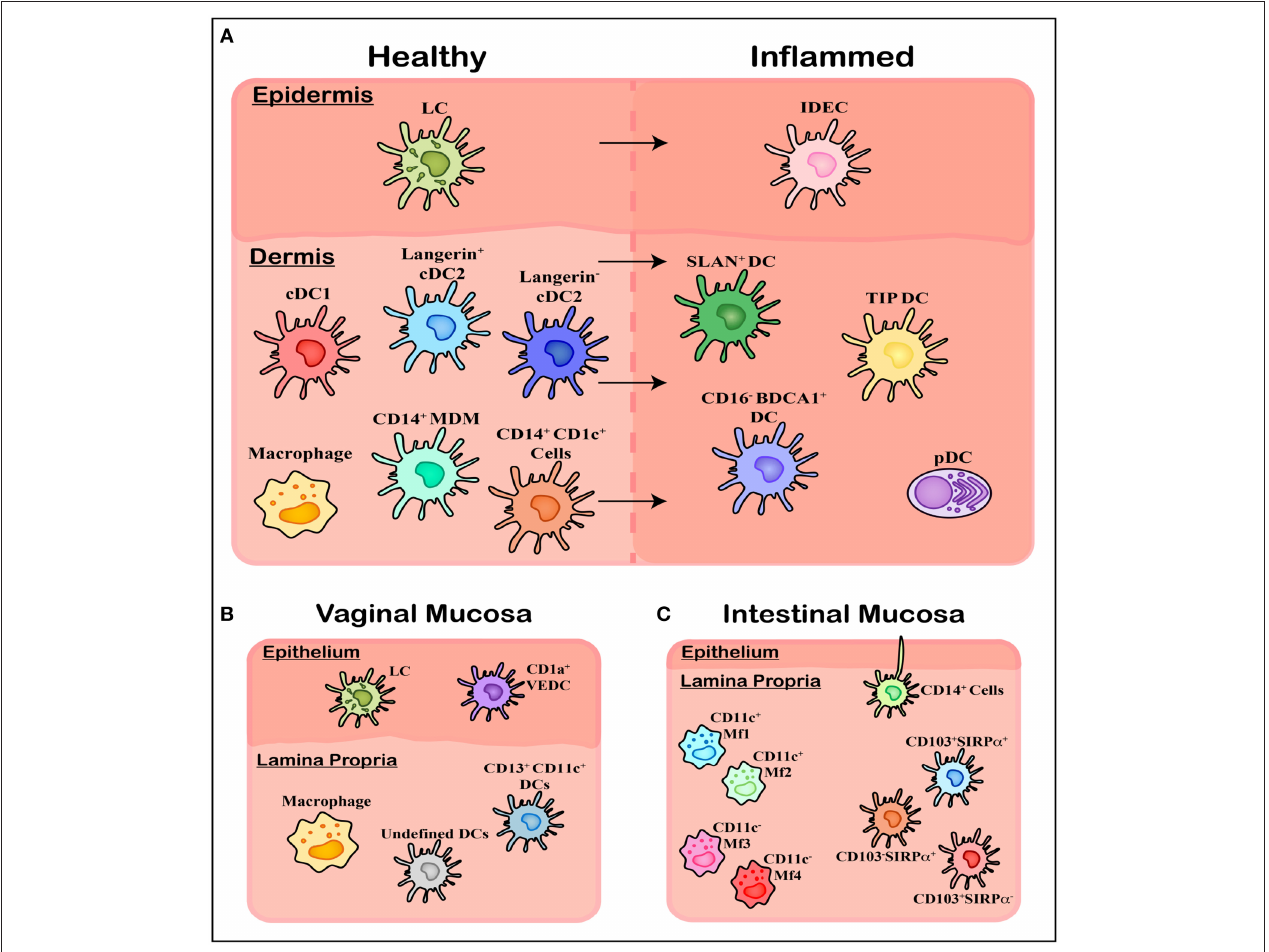
FIGURE 2 | Overview of mononuclear phagocyte subsets in human tissue. (A) Within healthy skin, it is believed Langerhans Cells (LCs) are the solitary population, however the underlying connective tissue of the dermis contains a range of subsets including cDC1, cDC2 (langerin expressing and langerin negative populations), and CD14 expressing cells including tissue resident Macrophages, Monocyte-Derived Macrophages (MDMs), and an uncharacterized CD1c + population. Upon inflammation these cells are also present however a number of other subsets of MNPs migrate in, including Inflammatory Dendritic Epidermal Cells (IDECs) in the epidermis, as well as pDCs, SLAN + DCs, TIP DCs, and CD16 − BDCA1 + cells in the dermis. (B) Within the vagina another novel population has been identified in epithelial layer, termed CD1a + VEDCs, while the underlying lamina propria has not been thoroughly characterized, with both macrophages and DCs present however exact subsets have not been extensively defined. (C) Within the lamina propria of intestinal tissue four separate CD14 + Macrophage populations (MF1-4) have been characterized by their CD11c + expression, while undefined CD14 + cells have been shown to extend dendrites through the epithelium to sample luminal microbes. Finally, CD103 and SIRP α can define three population of DCs which align with blood cDC1s, cDC2s, and CD14 +